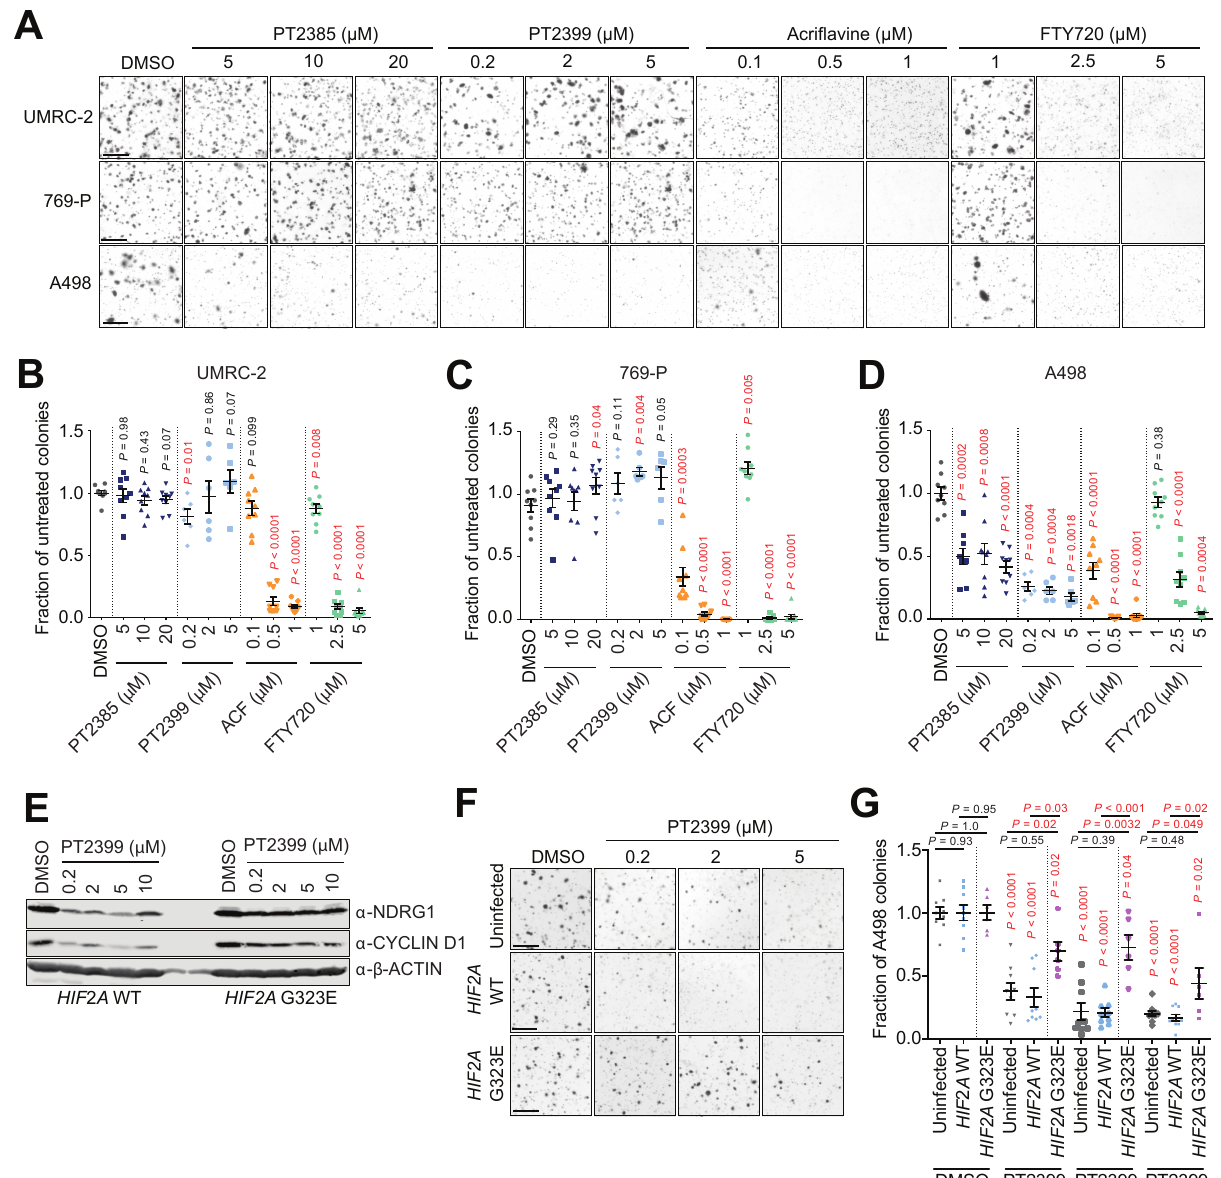
Figure 4. Inhibition of anchorage-independent growth of human ccRCC cells. ( A ) Representative images of stained soft agar colonies formed after 4 weeks of growth of UMRC-2, 769-P, and A498 cells in the presence of DMSO (control) or the indicated doses of the indicated drugs. Scale bar = 100 µ m. ( B – D ) Quantifications of colony formation, expressed as the fraction of colonies formed in untreated cultures in UMRC-2 ( B ), 769-P ( C ), and A498 ( D ) cells treated with the indicated doses of the indicated drugs. Data are derived from 2 (for PT2399) and 3 (all other treatments) independent experiments, each conducted in triplicate and are displayed as mean ± SEM. p -values for pairwise comparisons were calculated by Student’s t-test followed by two-sided Mann–Whitney U test without adjustments for multiple comparisons. ( E ) Immunoblots of HIF2A WT (left panel) and HIF2A G323E (right panel) for NDRG1, CYCLIND D1, and β -ACTIN after 48 h of treatment with DMSO or PT2399 in the indicated concentrations. ( F ) Representative images of stained soft agar colonies formed after 4 weeks of growth of A498, HIF2A WT, and HIF2A G323E cells in presence of DMSO (control) or the indicated doses of PT2399. Scale bar = 100 µ m. ( G ) Quantifications of colony formation, expressed as the fraction of colonies formed in cultures of A498, HIF2A WT, and HIF2A G323E cells treated with DMSO or PT2399 in the indicated concentrations. Data are derived from 2 ( HIF2A G323E) and 3 (A498 and HIF2A WT) independent experiments, each conducted in triplicate and are displayed as Mean ± SEM. p -values for pairwise comparisons were calculated by Student’s t -test followed by two-sided Mann–Whitney U test without adjustments for multiple